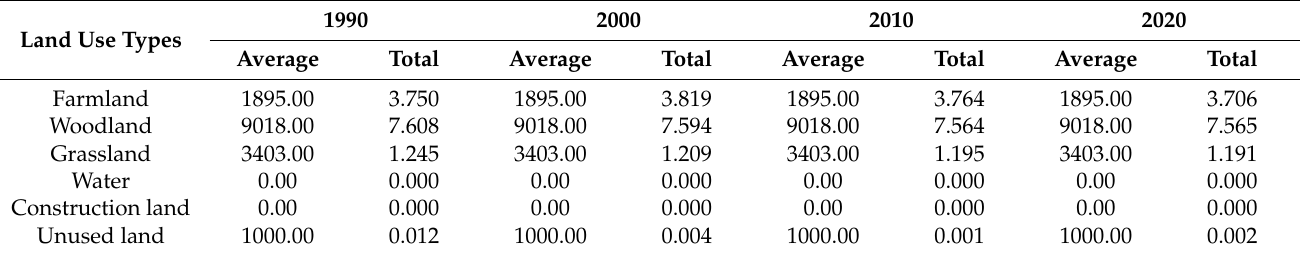
Table 5. Carbon storage (10 7 t) and average carbon density (t/km 2 ) of land use types in the Yellow River Basin (Henan section) from 1990 to